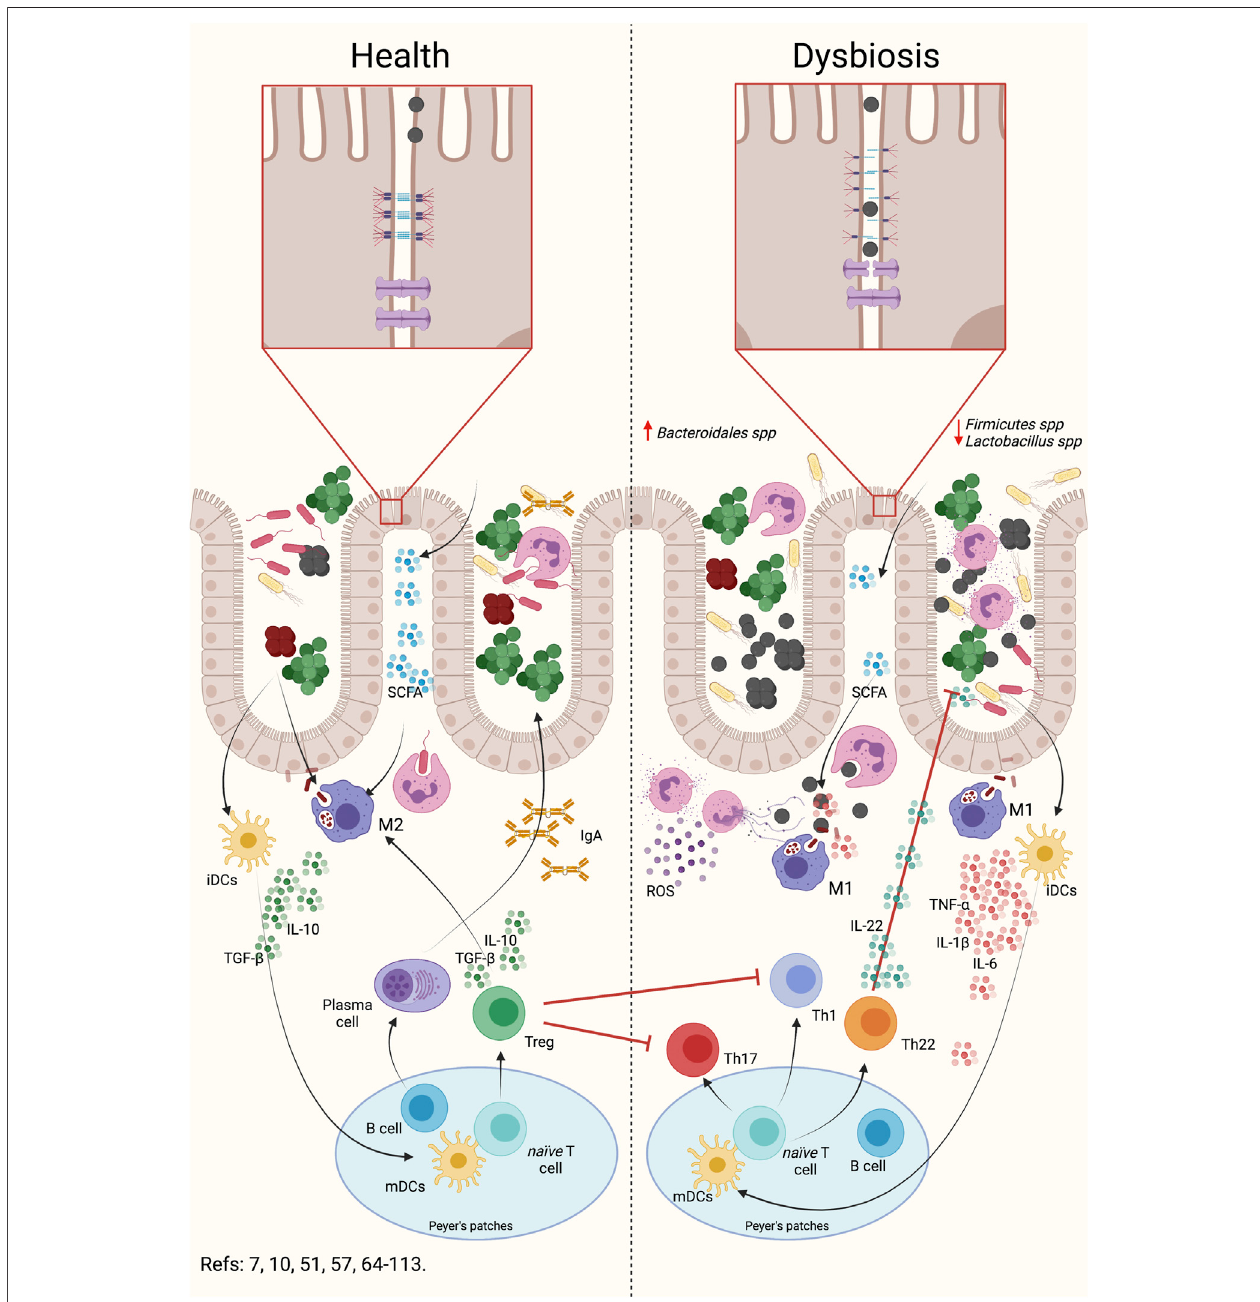
FIGURE 2 | Oral dysbiosis induce gut dysbiosis, intestinal barrier permeabilization and intestinal in fl ammation. During intestinal dysbiosis caused by periodontal anaerobic bacteria, there is an alteration in the Bacteroidales spp and Firmicutes spp rate. Intestinal dysbiosis produces an alteration in SCFA, increasing acetate and propionate and decreasing butyrate. This alteration can induce an activation of the in fl ammatory response in macrophages and neutrophils. As a consequence, dysbiosis triggers the permeabilization of the intestinal barrier by the rearrangement of the adherent junctions. This reorganization implies a modi fi cation in the locationandnumberofthesejunctions,whichallowsbacteriaortheirvirulencefactors toenterthesubmucosa.Onceinthesubmucosa,theprimary cellsoftheimmune system will engulf the bacteria and respond by secreting pro-in fl ammatory cytokines. Depending on the bacterial load or virulence factors that are entering, the primary immunecellsmaysecretechemokines,whichattract dendritic cells. Dendritic cellswillengulftheantigen,process it,internalizeit,and present toCD4 + Tlymphocytesin Peyer ’ spatchesorregionallymphnodes.Subsequentlyand,dependingontheantigenpresented,theclonalexpansionanddifferentiationoftheCD4 + Tlymphocytesto thedifferenteffectorphenotypeswilloccur.ThepresenceofTh1andTh17lymphocyteswillbeassociatedwithahigherpro-in fl ammatoryresponseandpermeabilization of the intestinal barrier. Evidence suggests that the presence of Th22 lymphocytes and IL-22 would in fl uence the proliferation of anaerobic bacteria, participating in the modulation of the permeabilization of the barrier. In addition, the presence of Treg lymphocytes will decrease the in fl ammatory response, allowing the recovery of